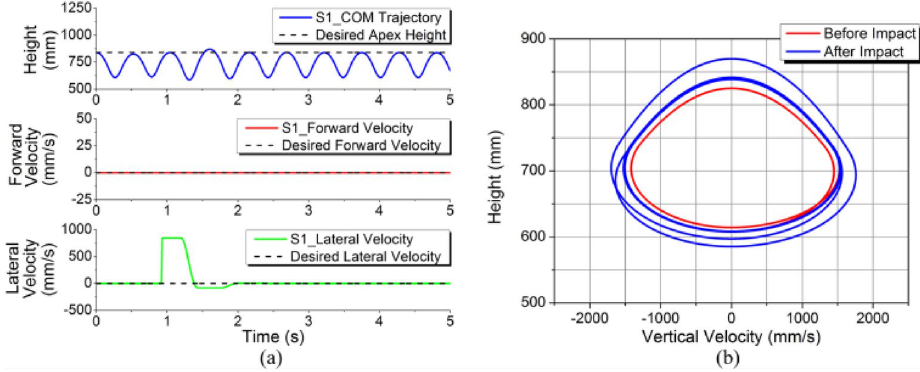
Figure 12. Simulation results for S1. ( a ) Body CoM trajectory, forward and lateral velocities. ( b ) Phase plane trajectory.